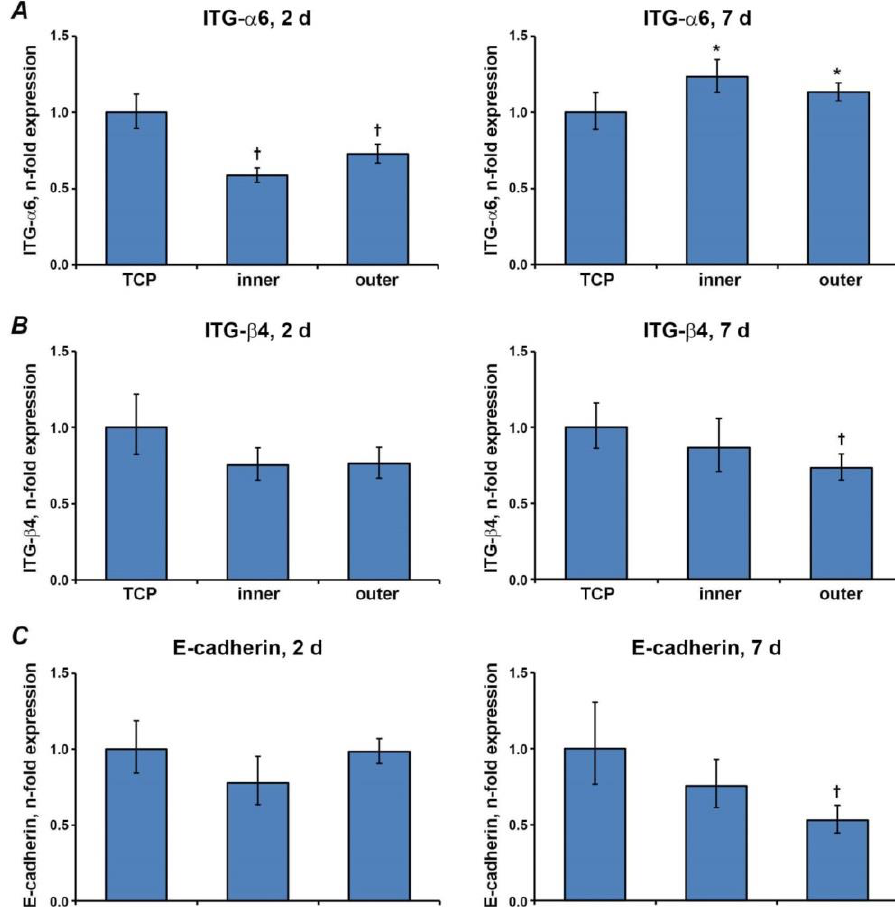
Figure 6. Gene expression of epithelial barrier markers in HOKs grown on different surfaces. Gene expression of ITG-α6 ( A ), ITG-β4 ( B ) and E-cadherin ( C ) after 2 and 7 days in HOKs grown on different aligners’ surfaces and TCP were measured by qPCR. Y-axes represent n-fold expression in relation to HOKs grown on TCP (n-fold expression = 1), which was calculated using the 2 −ΔΔCt method. Data are presented as the mean ± S.E.M. of four independent experiments. *—significantly higher compared to control; †—significantly lower compared to control; p < 0.05.